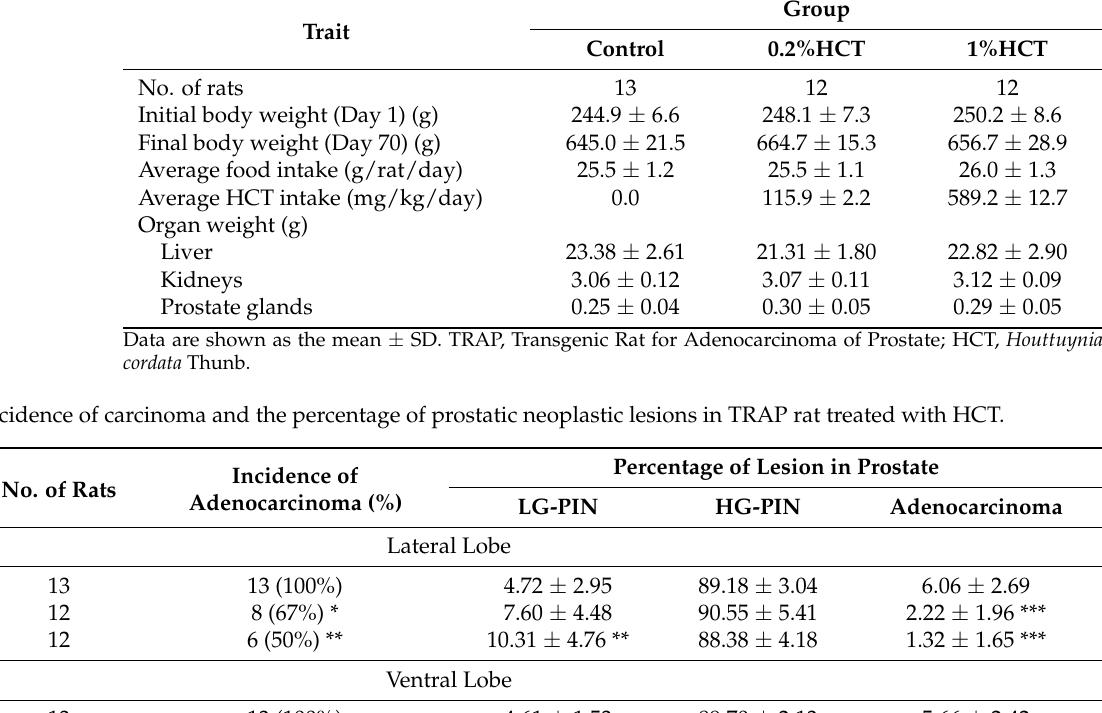
Table 2. Body, organ weights, and average HCT intake of TRAP rat fed with HCT. Trait